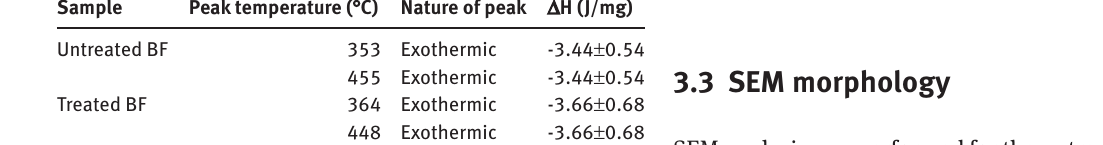
Table 1: Result of DSC analysis. Sample